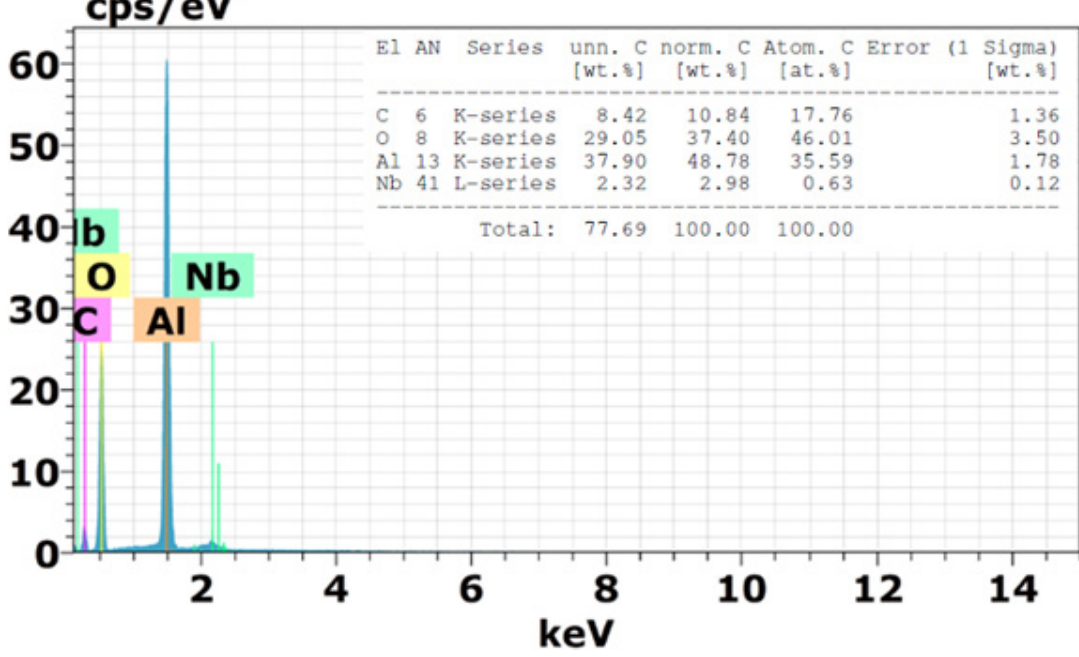
Figure 10. Energy dispersive spectroscopy (EDS) analysis of the PALF surface with ceramic aggregates.